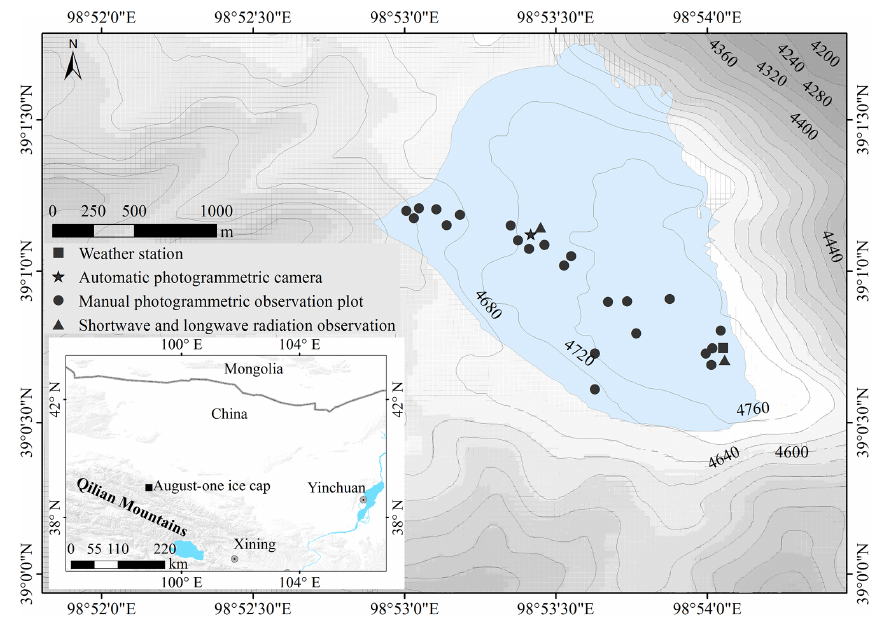
Figure 1. Location of ice cap and study sites. (a) Location of the August-one glacier. (b) Locations of the AWS, automatic and manual photogrammetry plots, and shortwave observation platforms. Table 1. Measurement specifications for the AWS located at the top of the glacier (4820ma.s.l.). The heights indicate the initial sensor distances to the glacier surface; the actual distances are derived from the SR50A sensor. Variable Sensors Stated accuracy Initial height (m) Air temperature Vaisala HMP 155A ± 0.2 ◦